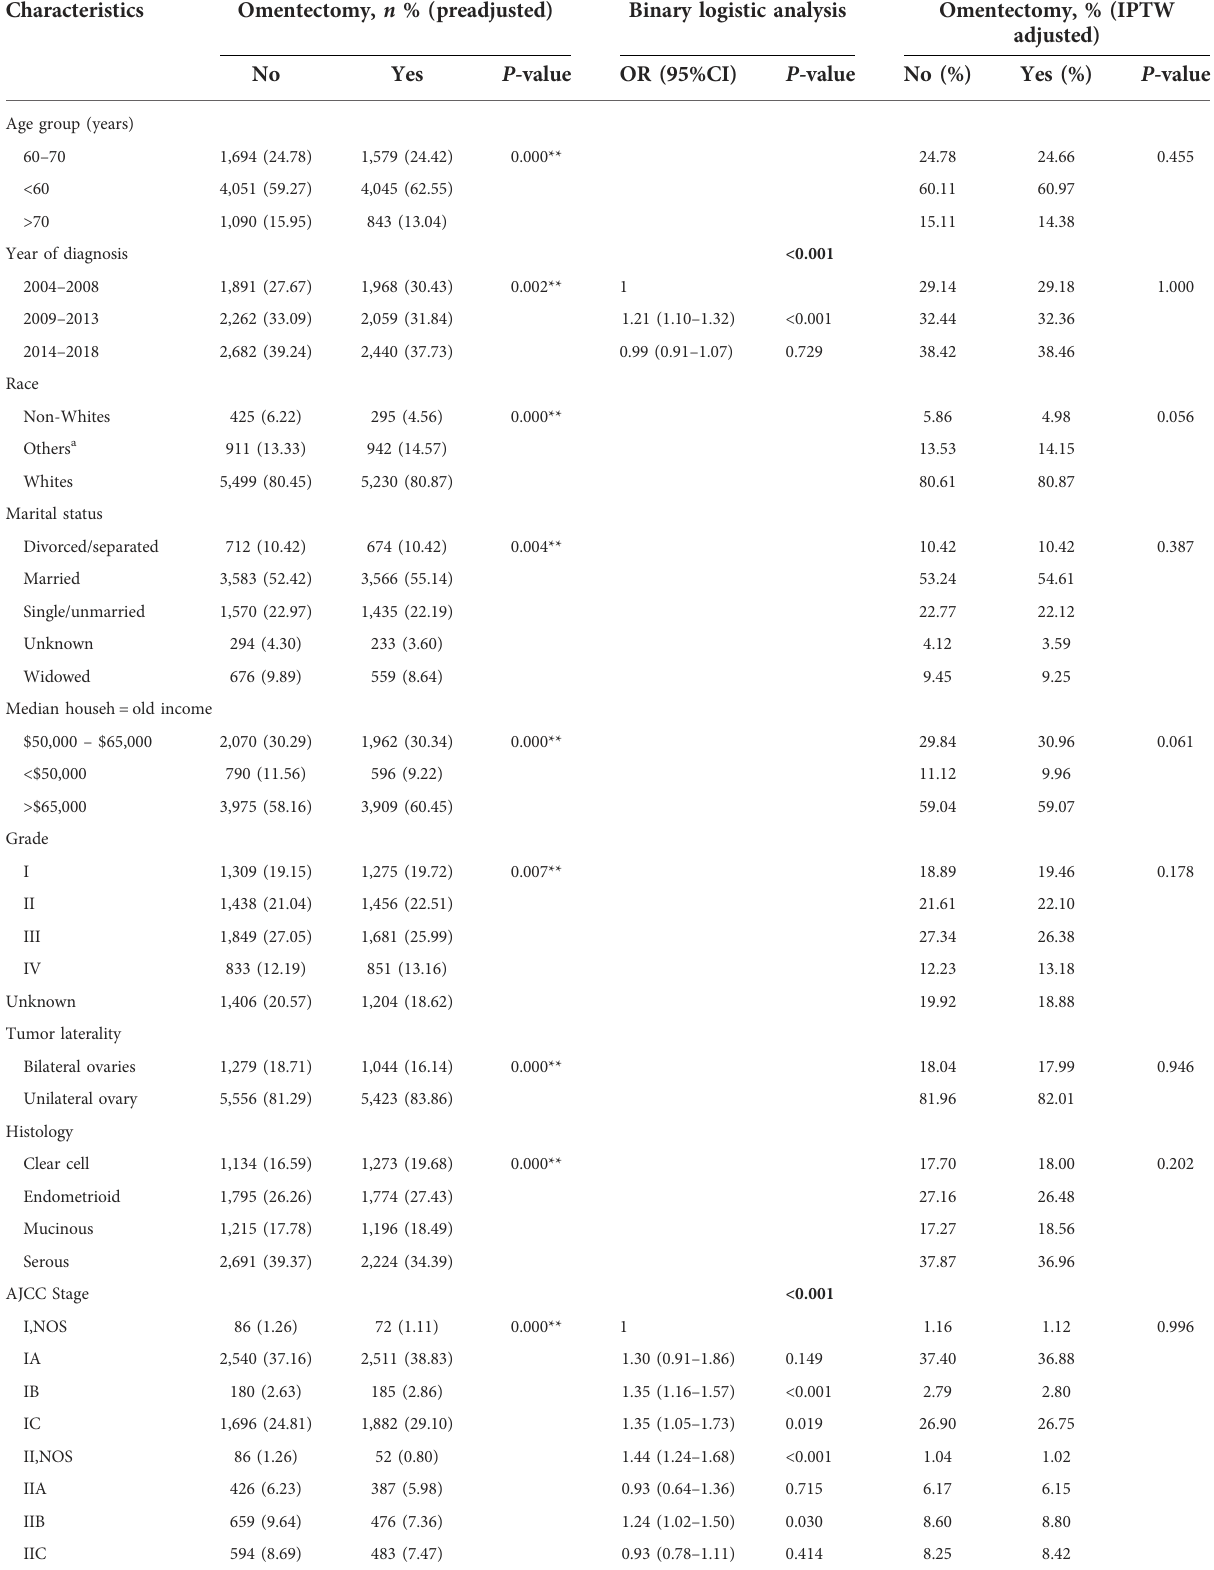
TABLE 2 Baseline characteristics before and after IPTW adjusted by omentectomy.